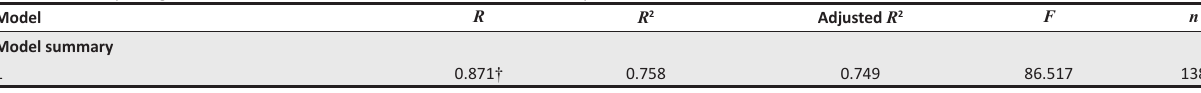
TABLE 5b: Multiple regression results for United Arab Emirates citizens and expatriates. Model